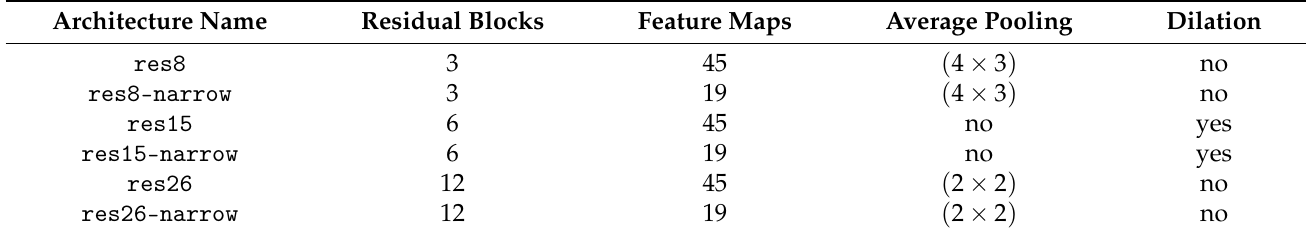
Table 1. Parameters of ResNet architectures used in the experiments. The names follow [15,31]. Architecture